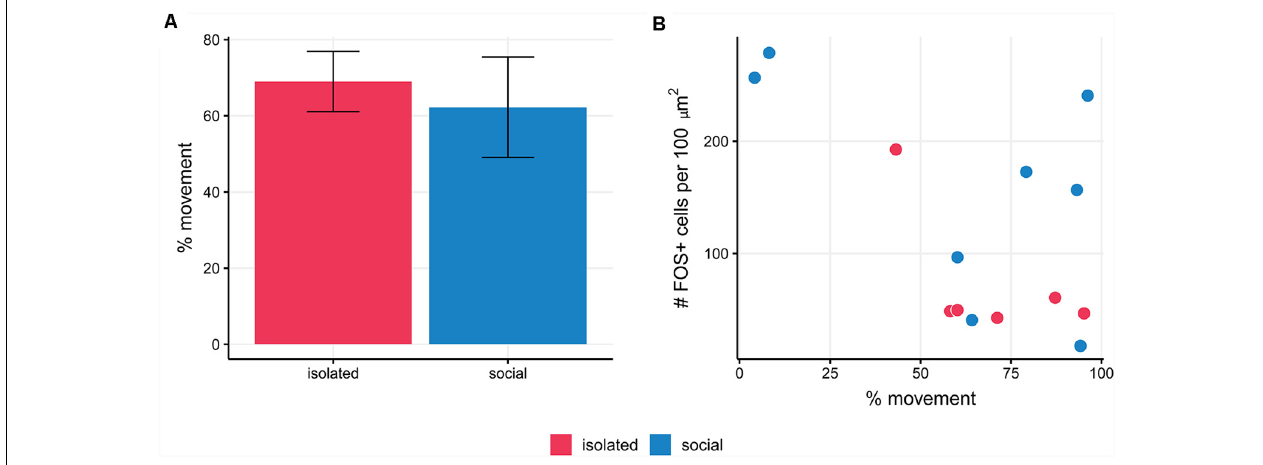
FIGURE 3 | (A) The percentage of movement in social males and isolated ones was similar ( p = 0.69). (B) The mean number of FOS+ cells per slice is not correlated with the percentage of movement in social and isolated males of B. gauderio ( p = 0.18).